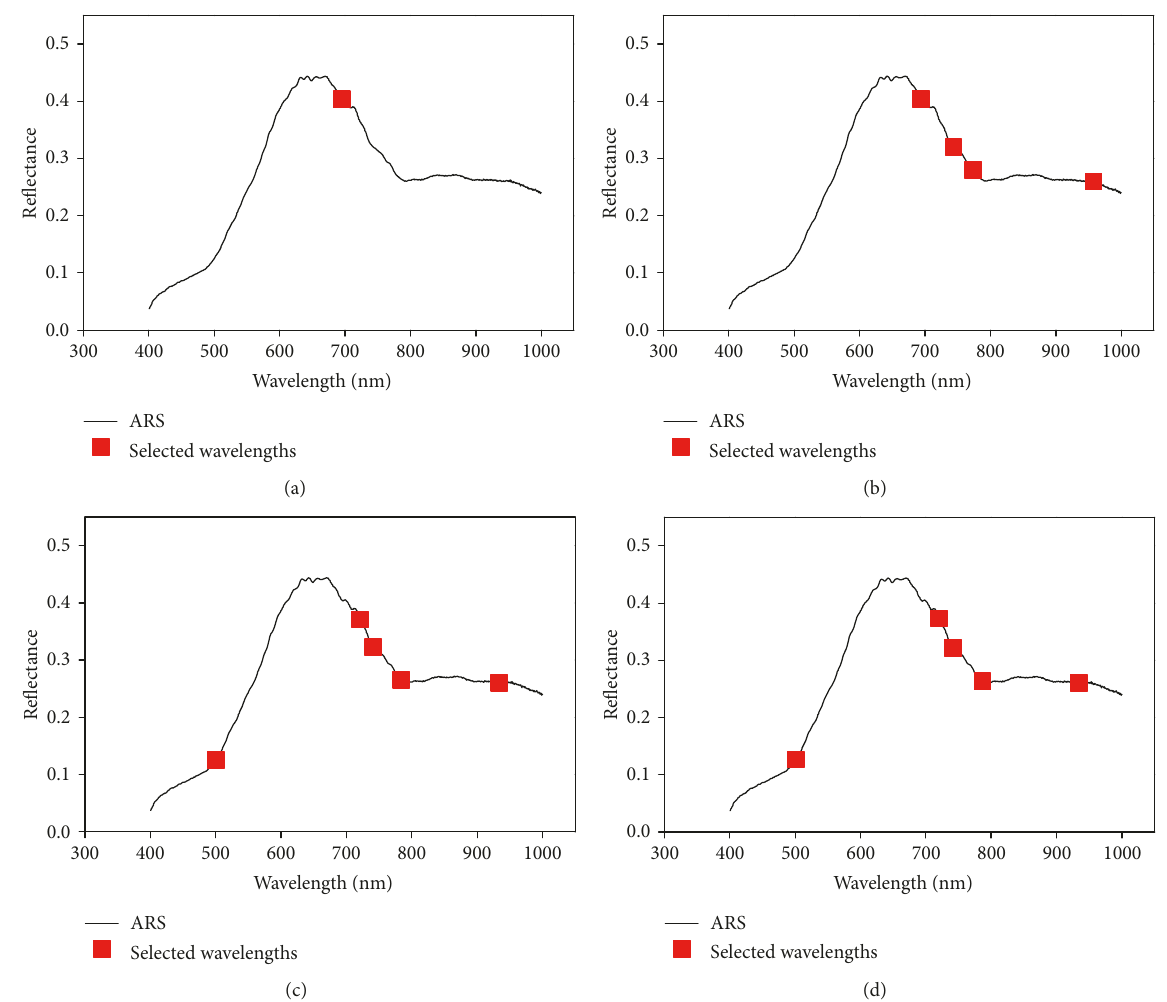
Figure 4: Selected CWs by SPA for no preprocessing (a), SG (b), MSC (c), and MSC-SG